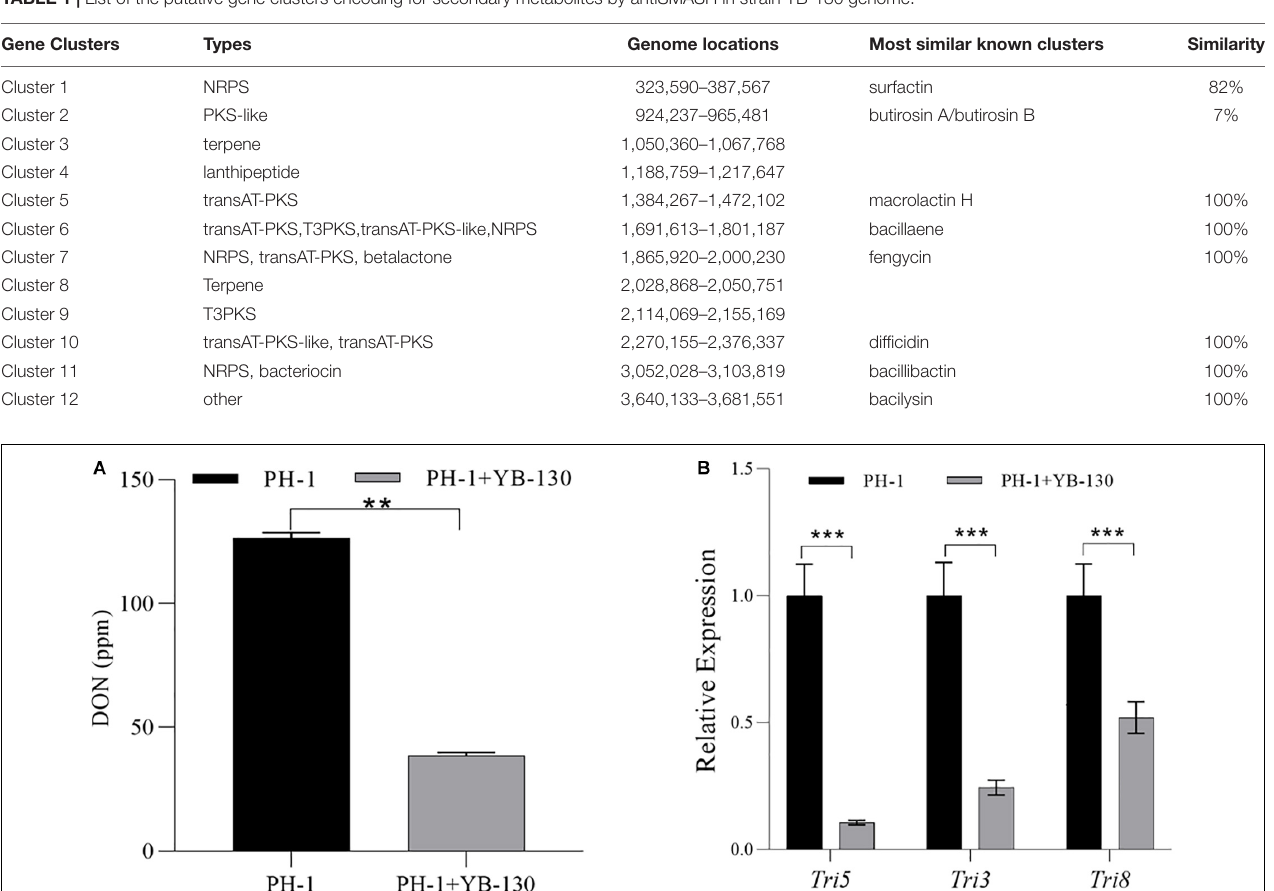
FIGURE 8 | Effect of strain YB-130 on DON production and tri gene expression in F. graminearum . (A) DON production in F. graminearum PH-1 co-cultivated with or without strain YB-130. Mean DON value ± standard deviation (SD) obtained from three replicates for each sample ( N = 3). ** P < 0.01. A two-tailed P value was calculated between n F. graminearum PH-1 co-cultivated with or without strain YB-130 by T -test. (B) Expression of tri5, tri3 and tri8 in F. graminearum PH-1 co-cultivated with or without strain YB-130. Data were Mean ± standard deviation (SD) obtained from three replicates for each sample ( N = 10). *** P < 0.001. Two-tailed P values were calculated between n F. graminearum PH-1 co-cultivated with or without strain YB-130 using T